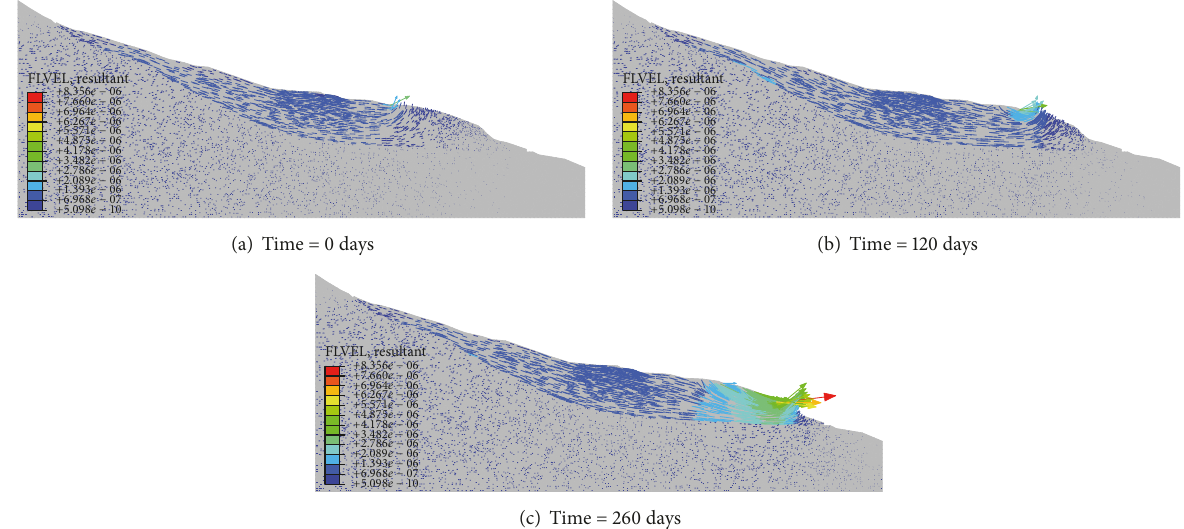
Figure 10: Pore water effective velocity over time under the coupling effect of rainfall and reservoir water level variation (unit, m ⋅ s −1 ).